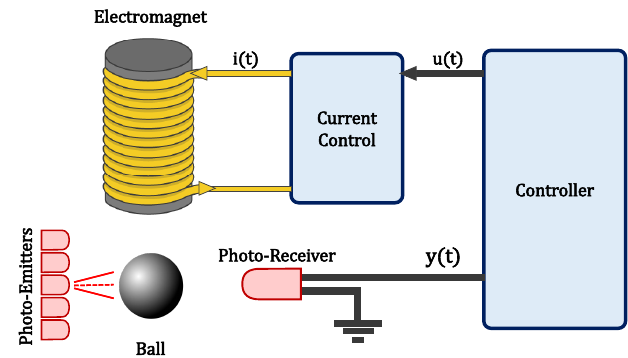
Figure 1. Diagram of Magnetic Levitation